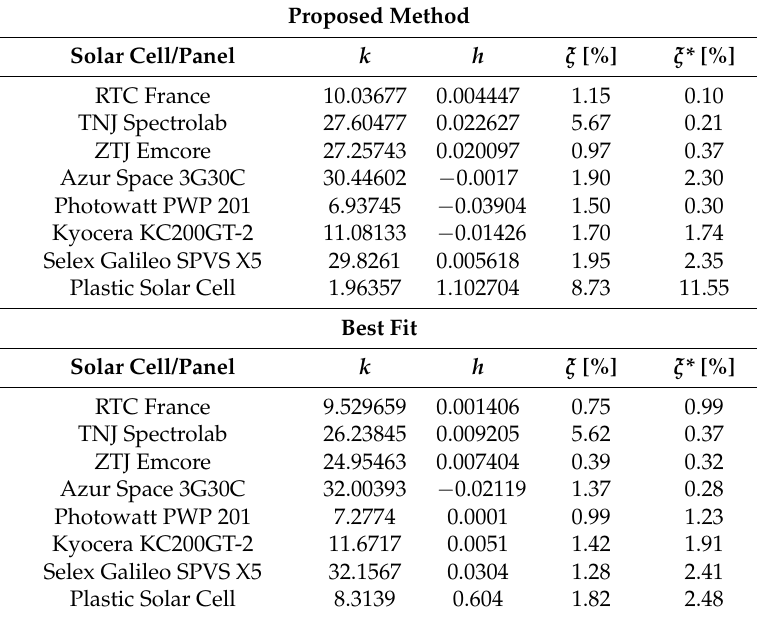
Table 7. Parameters from Das’s explicit model (Equation (30)), fitted to the I – V curves for the photovoltaic devices studied (see Table 1). The fittings were performed numerically (best fit), and using the proposed method (Equation (33)). The normalized RMSE values of the fittings, ξ , and ξ * , are included in the table.